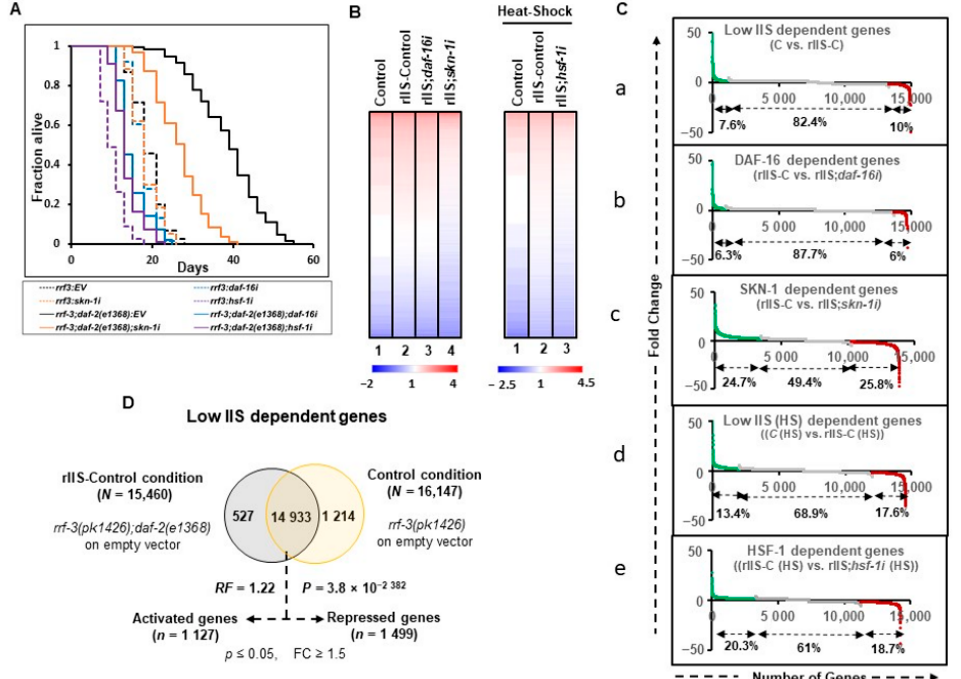
Figure 1. Global transcriptional outputs of transcription factors affecting class 1 rIIS receptor mutant longevity. ( A ) Life-spans of mutants rrf-3(pk1426) and rrf-3(pk1426);daf-2(e1368) on empty vector (EV), daf-16, skn-1, and hsf-1 RNAi. Strains of rrf-3( − ) and rrf-3( − );daf-2( − ) on the empty vector (EV) were marked as “control (C)” and ‘rIIS-Control (rIIS-C)”, respectively. The knockdown of daf-16 and hsf-1 genes reverts the lifespans of rIIS mutant ( rrf-3( − );daf-2( − ) ) close to control levels, while it partially depends on skn-1 RNAi. ( B ) DAF-16, SKN-1 and HSF-1dependent genes were identified by feeding rrf-3( − );daf-2( − ) animals on daf-16, skn-1 and hsf-1 RNAi, respectively. Heat-map representation of the total gene expression by RNA-Seq (log 10 RPKM values) contributing to (left panel) control: lane 1, rIIS: lane 2, DAF-16 dependent genes: lane 3, and SKN-1 dependent genes: lane 4, (right panel) control (HS): lane 1, rIIS (HS) dependent genes: lane 2, and HSF-1 (HS) dependent genes: lane 3. Strong knockdown of TFs by the RNAi represented by the lowered expression values in TFs knockdown conditions compared to rIIS. ( C ) Significant fold change, ( a ) rIIS vs. control at 20 °C, ( b , c ) rIIS vs. rIIS mutant on daf-16, skn-1 RNAi, ( d ) rIIS (HS) vs. control (HS) at 33 °C for 2 h, and ( e ) rIIS (HS) vs. rIIS (HS) on hsf-1 RNAi. At the genome-wide level, differentially expressed genes due to DAF-16 are less than that of SKN-1 and HSF-1. Activated and repressed genes were shown by green and red colors, respectively. ( D ) Venn diagram shows the overlap among genes that are differentially expressed during low IIS conditions. Genes selected with p ≤ 0.05 and fold change ≥ 1.5. P: Hypergeometric p -value, HS: heat-shock, RF: representation factor, FC: fold change.